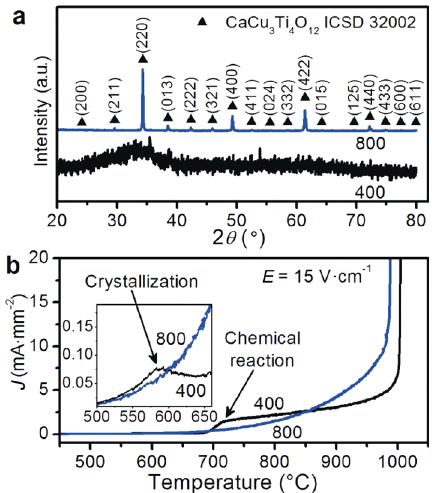
Fig. 4 (a) XRD patterns of the CCTO precursor powder after heat treatment at 400 and 800 ℃ for 2 h. The powder is amorphous at 400 ℃ , while a single CCTO phase is synthesized at 800 ℃ ; (b) temperature dependence of current density ( J ) for the two powders during processing under a field of 15 V·cm − 1 . In the course of sintering, only the amorphous powder shows the anomalies related to crystallization and chemical reaction.